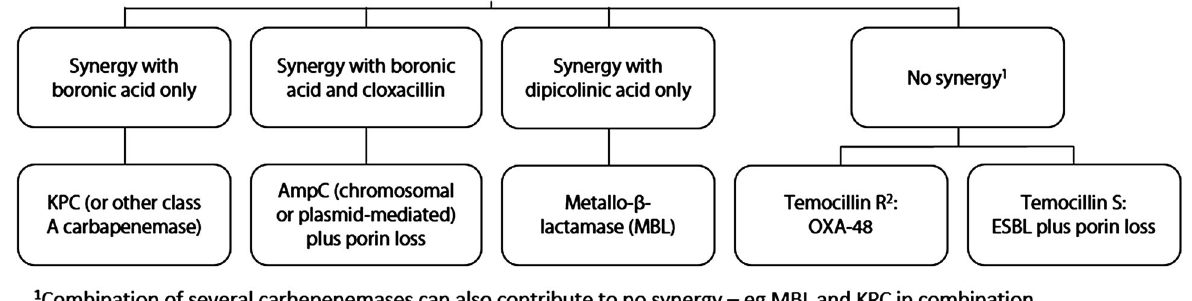
Figure 6: Carbapenemase-producing Enterobacteriaceae (CPE) screening using combined disk tests.